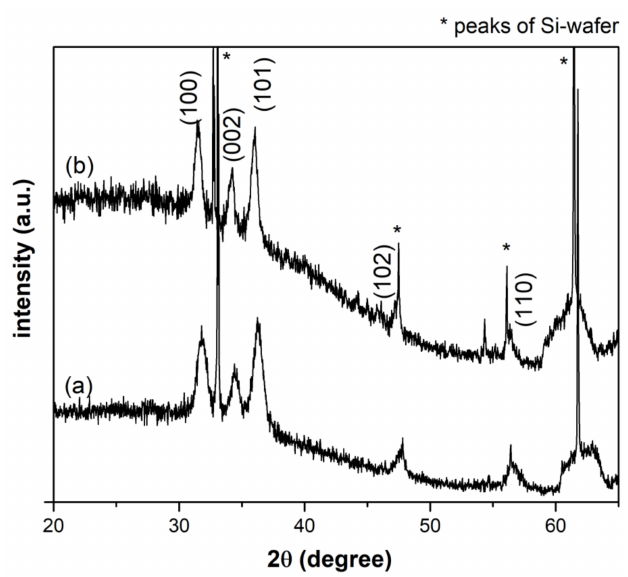
Figure 1. X-ray diffractogram of the pristine ZnO nanocrystals (NCs) obtained via ( a ) conventional (ZnO-st NCs) and ( b ) microwave-assisted synthesis (ZnO-mw NCs).